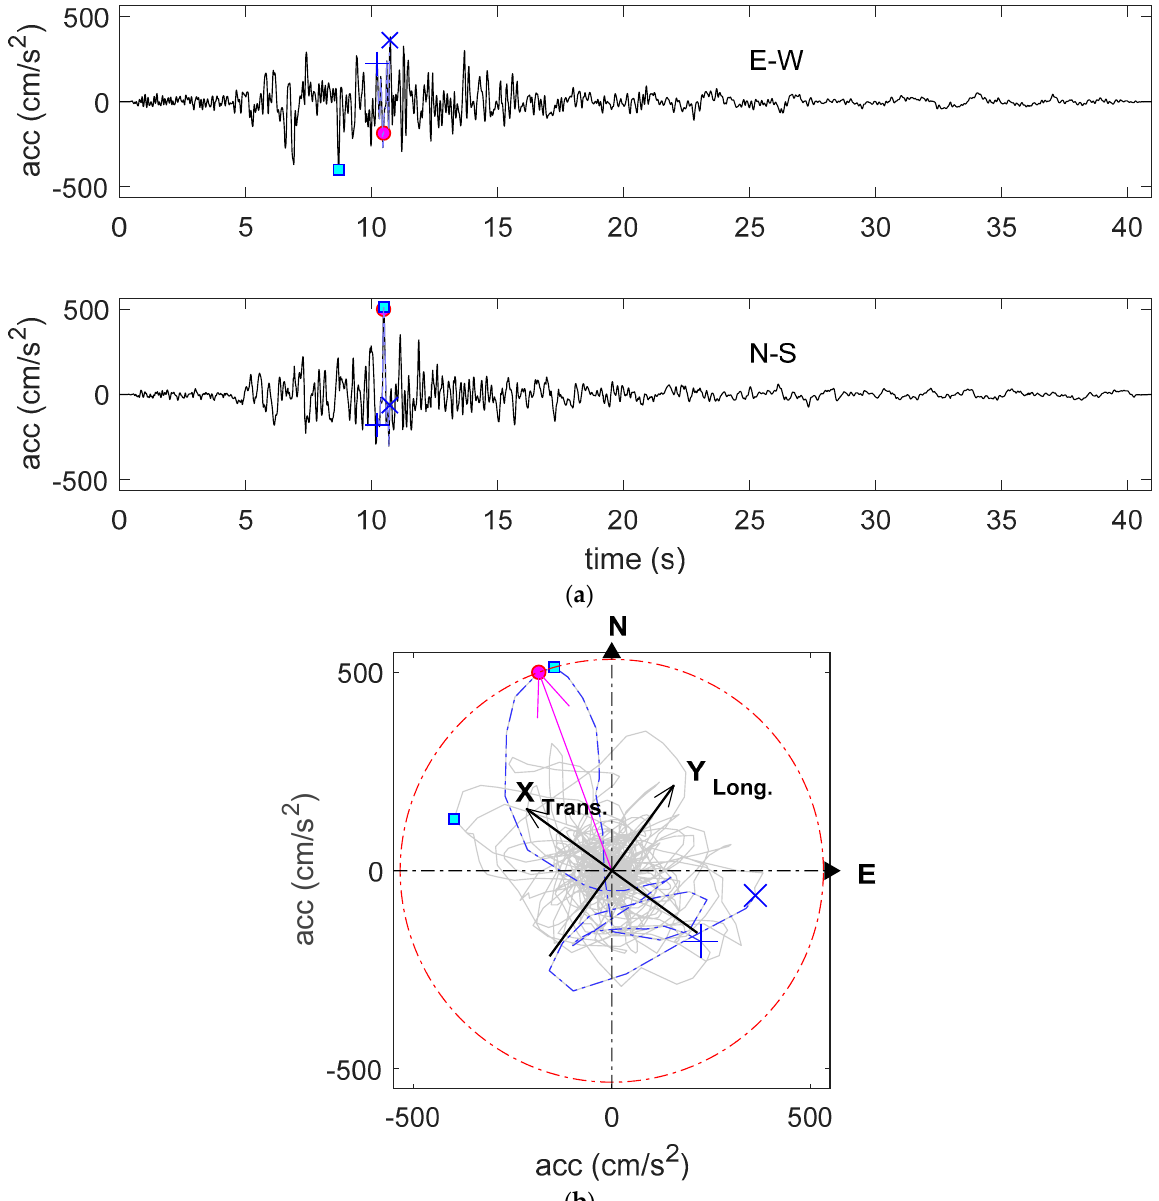
Figure 15. 2016 M W 7.8 Ecuador earthquake recorded at AMNT station. ( a ) As-recorded E-W and N-S accelerograms, and ( b ) acceleration hodogram.